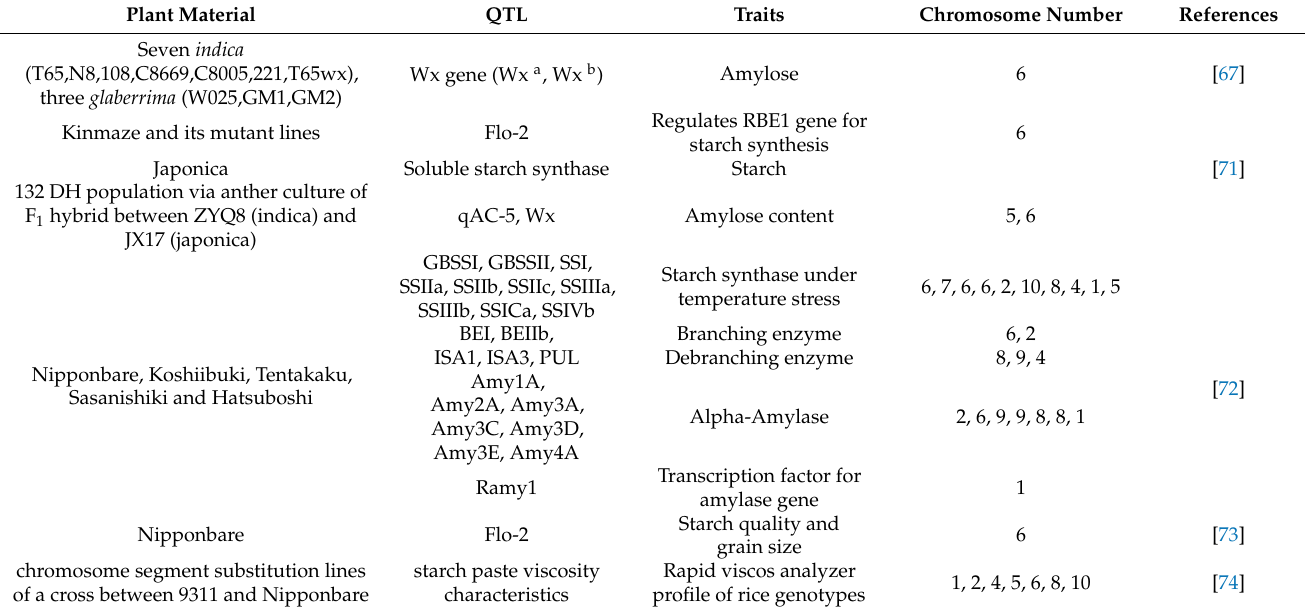
Table 3. Quantitative traits loci for endosperm starch and their importance in rice grain